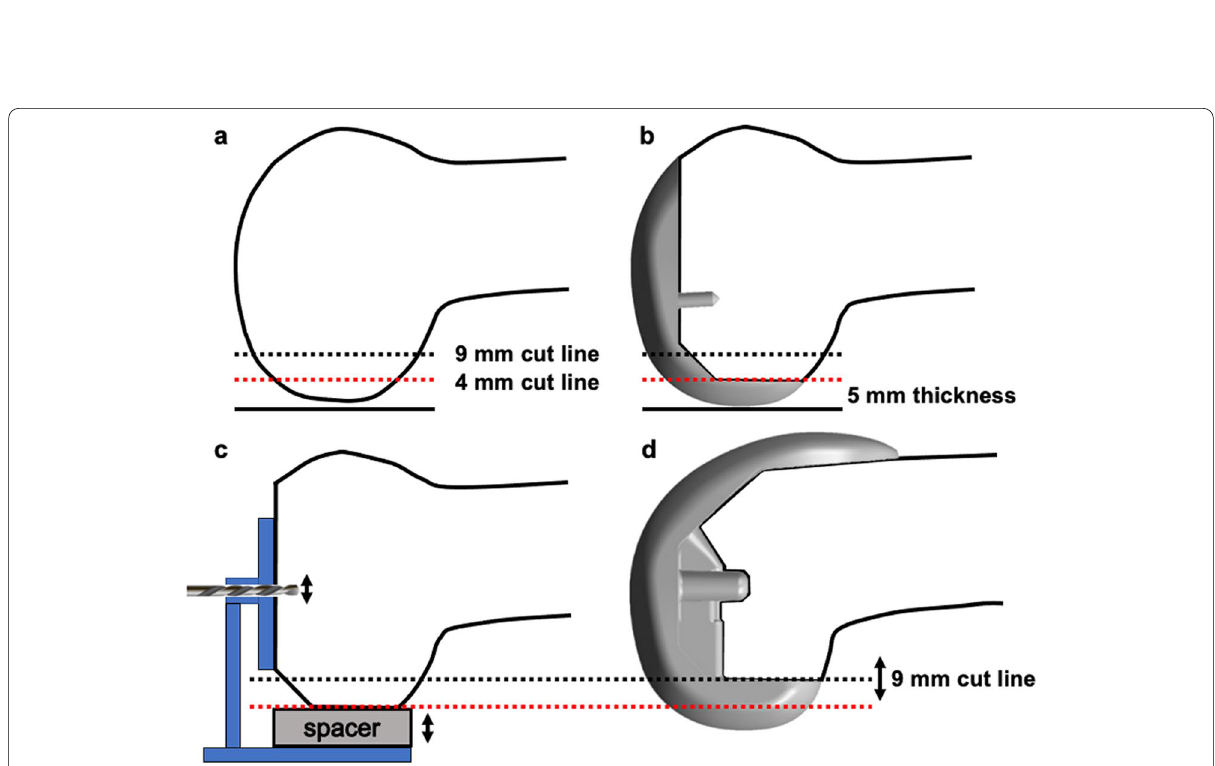
Fig. 2 Procedure from the initial bone cutting to setting the final component. First, a 4-mm pre-cut (red dotted line) was performed ( a ). Second, PS PCT was set on the pre-cut surface ( b ). According to the gap measurement, after adjusting the cutting line of the posterior condyle posteriorly or anteriorly, a drill hole is made to install the cutting device ( c ). When the flexion gap was larger (or smaller) than the extension gap, a surgeon could control the additional cutting line (black dotted line) posteriorly (or anteriorly) in 1-mm increments using a thicker (or thinner) spacer ( c ). Lastly, the femoral trial component was set after flexion gap control ( d ). PS PCT, posterior-stabilised pre-cut trial